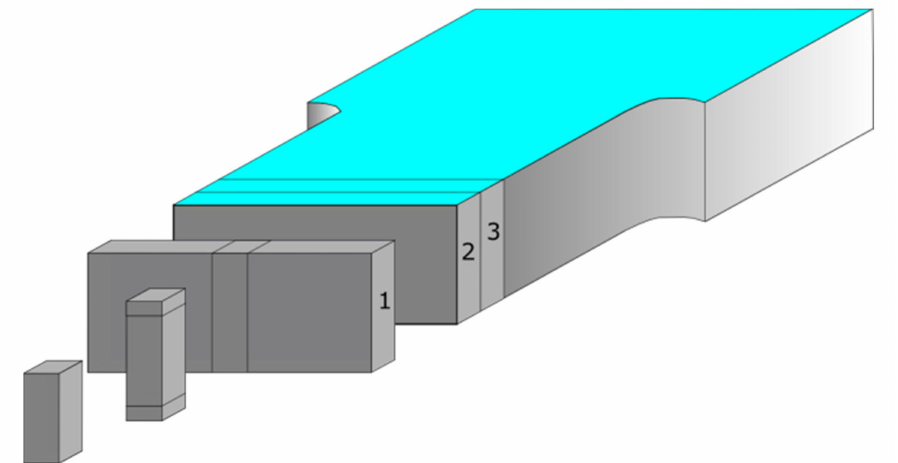
Figure 5. Samples for DSC measurements, schematically presented as the smallest piece in front of the graphic, were taken from three separated stripes (marked as 1, 2, 3) cut in the measurement part of molded